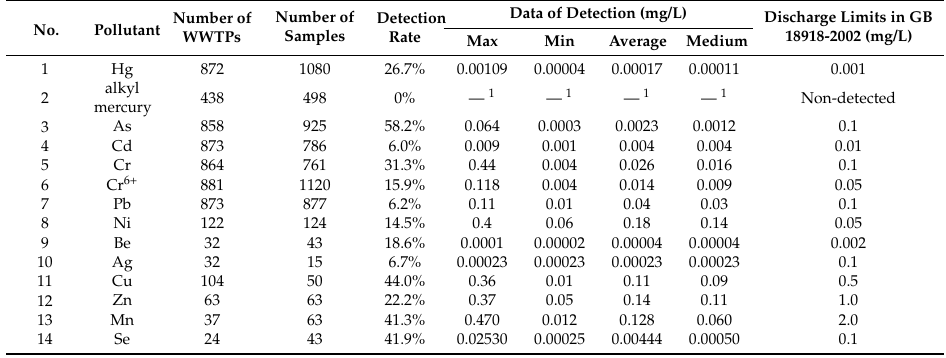
Table 2. Discharge concentrations of 14 heavy metals and metalloids in wastewater treatment plants (WWTPs) of